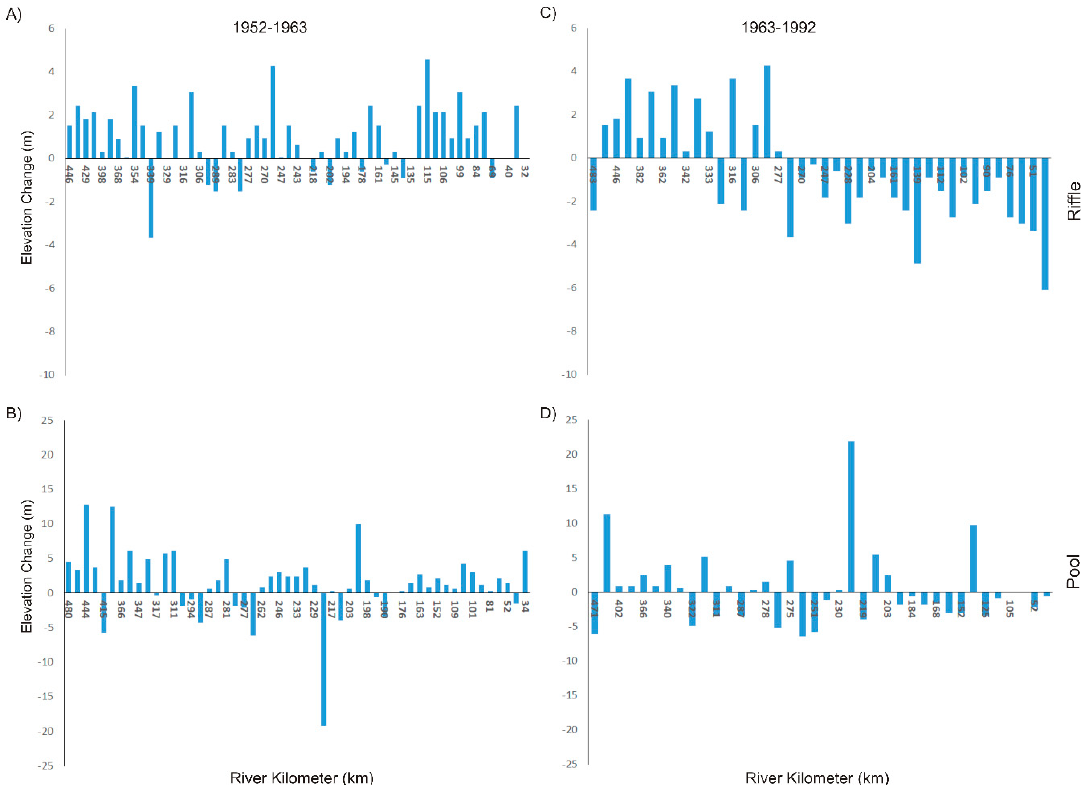
Figure 14. Elevation change of pools and riffles from 1952–1963 ( A for riffles and B for pools) and 1963–1992 ( C for riffles and D for pools). The decreases (<0) and increases (>0) are determined by reference to the x -axes at 0. We compared the differences in elevation for the same pools or riffles during these two time spans.